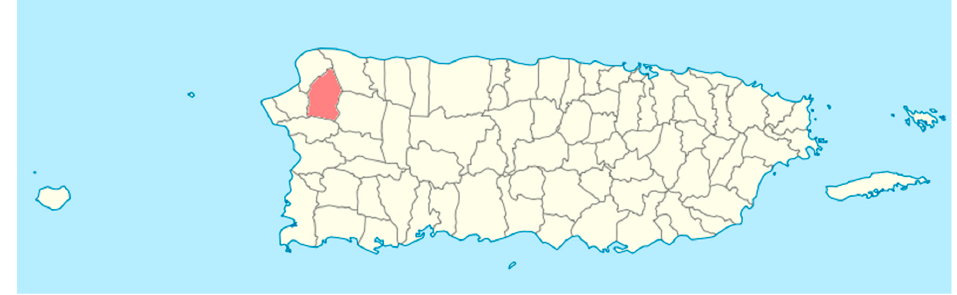
Figure 3. Location of Moca, Puerto Rico. Based on File: USA Puerto Rico location map.svg made by NordNordWest, highlighted by Dr. Blofeld—Based on File: USA Puerto Rico location map.svg. In nineteenth to mid-twentieth century Moca, the ward ( barrio ) was a rural area subdivided into small and large plantations; today a barrio can contain housing subdivisions and some farms. The port of Aguadilla, through which many emigrants from Saint Domingue/Haiti arrived during the early to mid-1800s, lies about five miles west of Barrio Pueblo; to the east are Isabela, San Sebastian, and Lares, which figure in the larger history of Lasalles and Lassalles, enslaved and free. The spelling of the surname goes back and forth over time, beginning as Lasalle and becoming Lassalle across different documents.